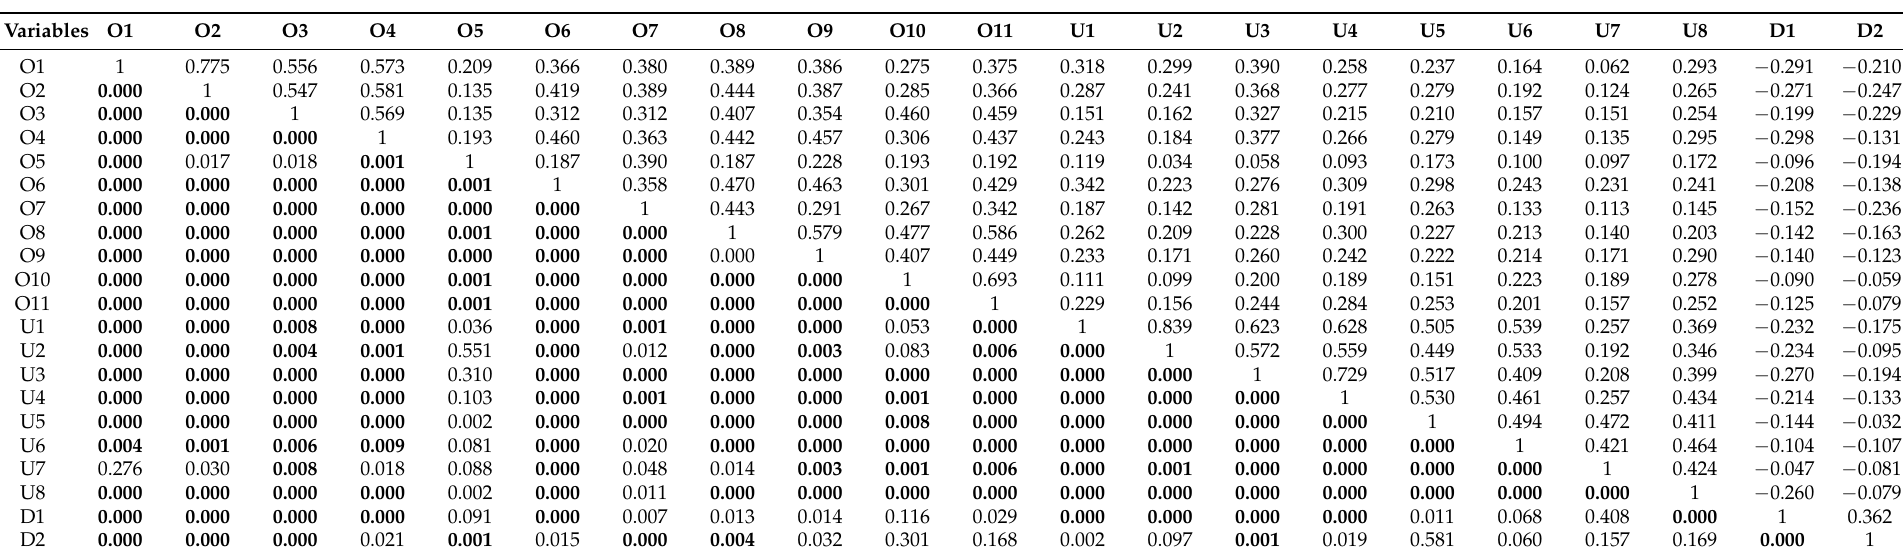
Table 5. Significant correlations of Spearman’s rho ( p < 0.01) between